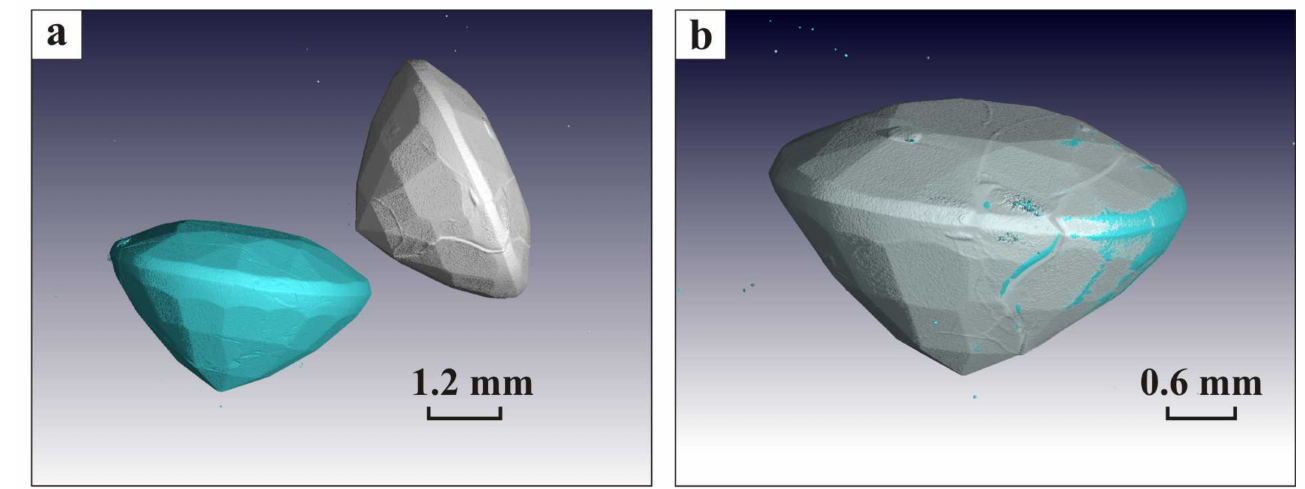
Figure 8. Images of the 3D mesh files created on the exterior surface of the glass-filled ruby. ( a ) Two iterations at slightly different threshold values produced mesh files indicated in blue and grey. ( b ) The overlap of the two mesh files after using the best-fit registration method. Slight deviations between the two wireframes are shown where the blue mesh protrudes the grey mesh. Distinct features and their overlap remain